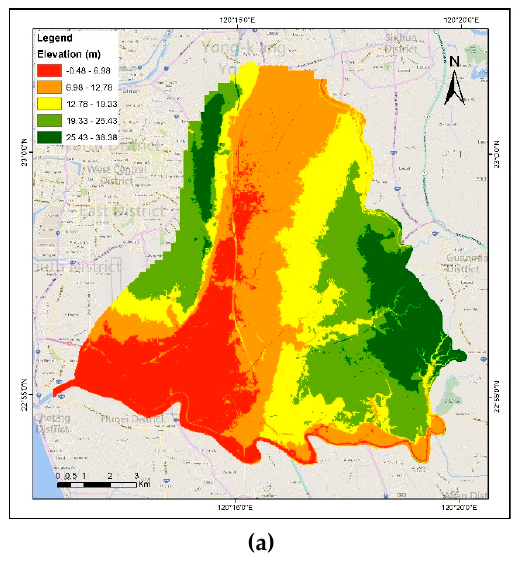
Table 2. Vulnerability weight values from the AHP.